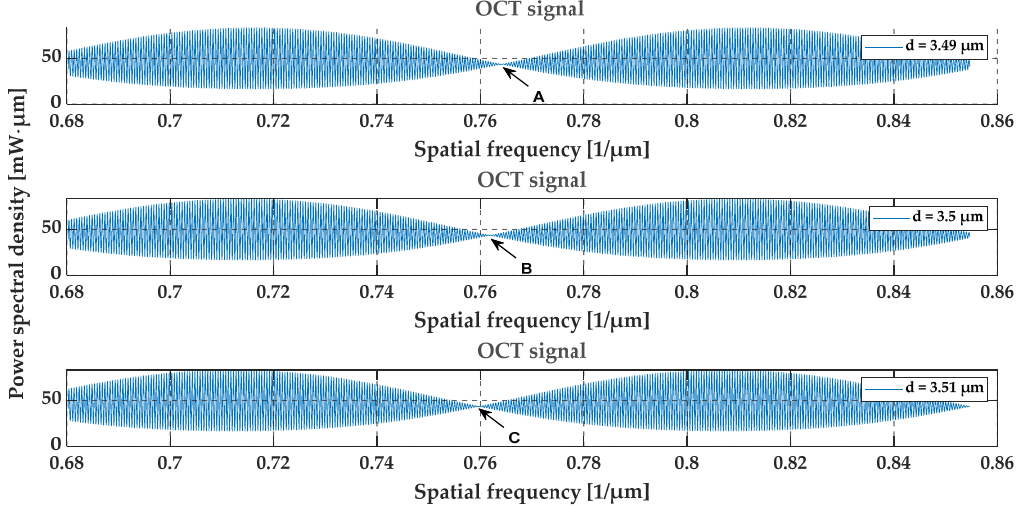
Figure 9. The OCT signal for glass foils for the uniform spectral characteristic of the light source. The arrows (A, B, C) show the discussed points.